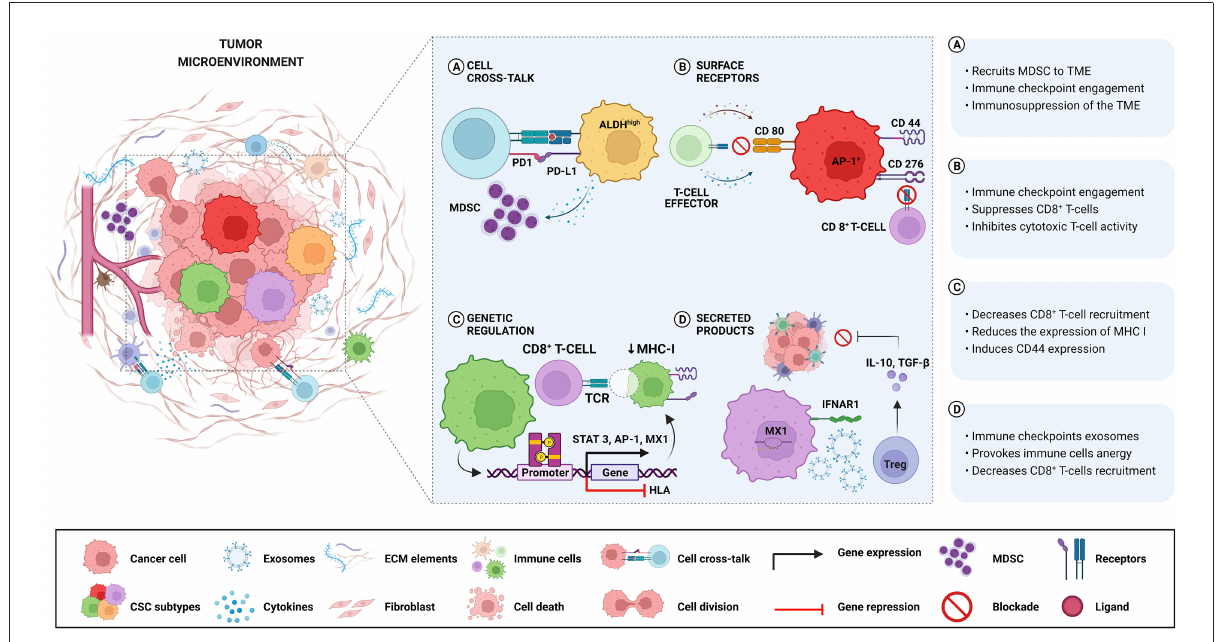
FIGURE1 Different mechanisms involved in immune escape are driven by Oral and HNCSCs. (A) ALDH high -CSCs exhibit higher levels of PD-L1 and recruit MDSC with a suppressive role, causing negative regulation of immune responses in the TME. (B) CSCs expressing CD276 and AP-1 create a continuous positive feedback that enables immune evasion by suppressing CD8 + T cells. After TGF- β stimulation, CSCs express CD80 and inhibit T cell cytotoxicity leading to resistance to T cell immunotherapy. (C) The activation of the STAT3 pathway is related to the expression of PD-L1 in CD44 + cells, resulting in immune escape played by CSCs. Downregulation of HLA genes in CSCs decreases the expression of MHC class I causing non-recognition by T cells. (D) High expression of MX1 in CSCs decreases CD8 + T-cells infiltration concomitant with IFNAR1 expression associated with the release of exosomes containing immune checkpoint receptors. Noteworthy, the same CSCs can activate more than one immune avoidance